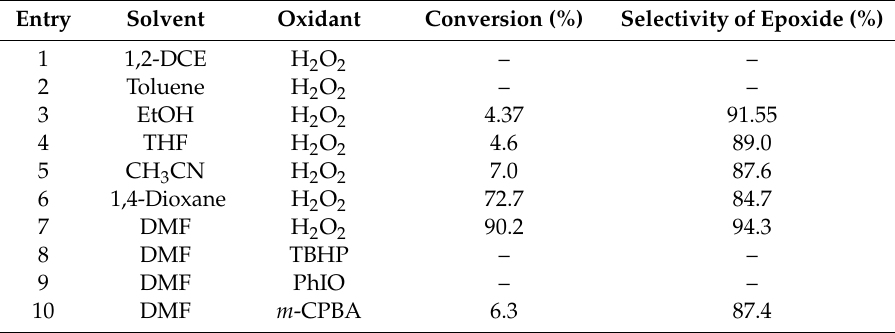
Table 2. E ff ect of solvent and oxidant on the catalytic epoxidation of